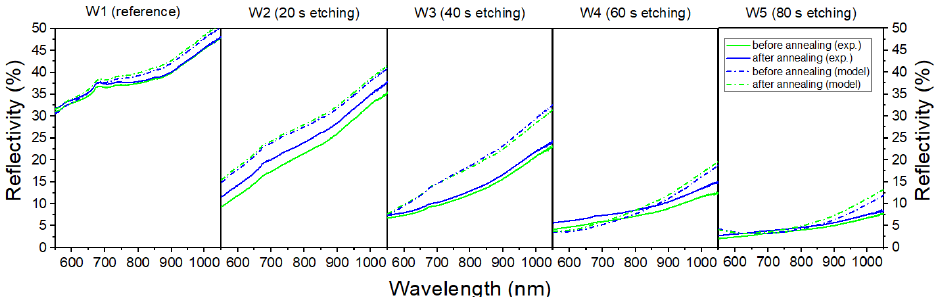
Figure 2. Experimental reflectivity spectra measured at room temperature (solid lines) for unpolarized light before (green) and after laser annealing (blue), and theoretical curves (dashed lines) obtained with Equation